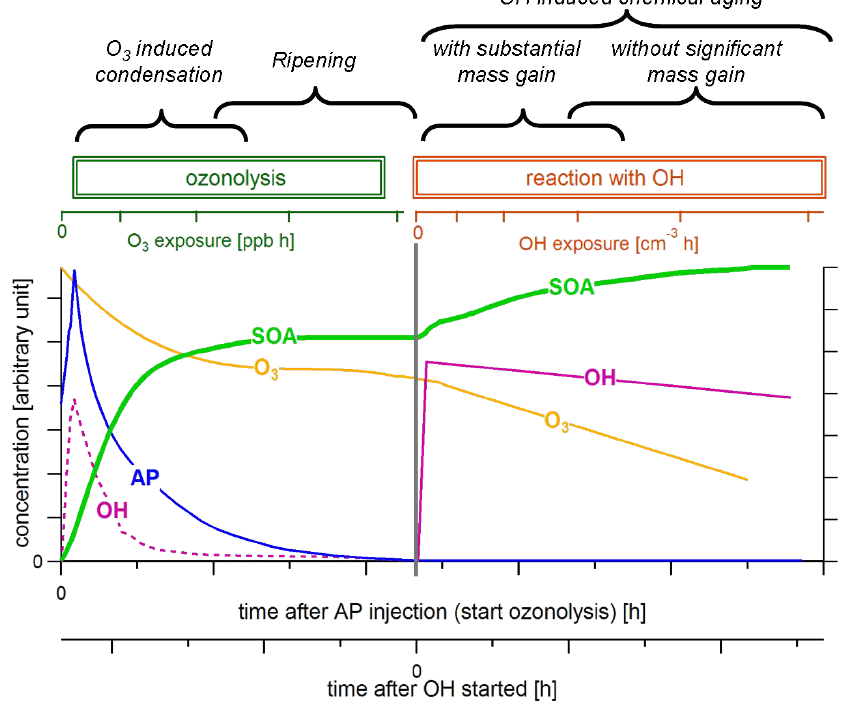
Fig. 1. Schematic of the main features of the smog chamber experiments during MUCHACHAS. Formation of secondary organic aerosol (SOA) mass (wall-loss corrected) from the volatile organic precursor α -pinene (AP) takes place during the first part in dark with ozone (O 3 ). The ozonolysis is followed by OH chemistry to age the SOA. The data can be plotted against several time axes as “time after AP injection was started” and “time after the OH reaction started” or against a “chemical clock” as O 3 exposure and OH exposure. During ozonolysis and reaction with OH the four different periods of our experiments are indicated above the figure: O 3 induced condensation, ripening, OH induced chemical aging with substantial mass gain, and OH induced chemical aging without significant mass